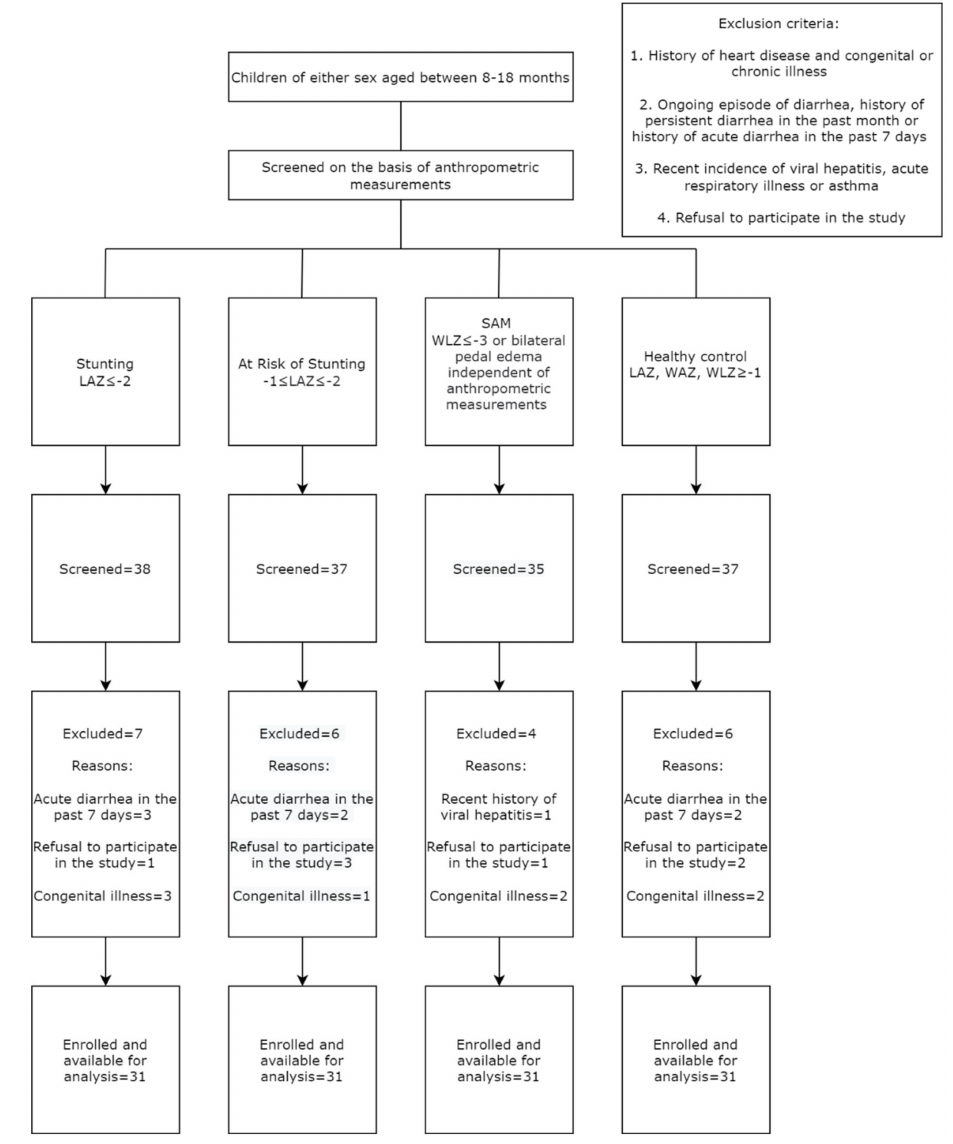
Figure 1. Flow chart showing the inclusion of the participants in the study. Measurement of length (to the nearest 0.1 cm) and weight (to the nearest 0.1 kg) of the study participants was conducted by using a portable infantometer and weighing scales (Seca, Hamburg, Germany). Head circumference (to the nearest 0.1 cm) was measured us- ing measuring tape, while mild-upper arm circumference (to the nearest cm) was measured using MUAC tape (Maternova, Providence, RI, USA). All anthropometric measurements were conducted by trained research assistants and standardized protocols for anthropo- metric measurements described elsewhere were followed all throughout the study